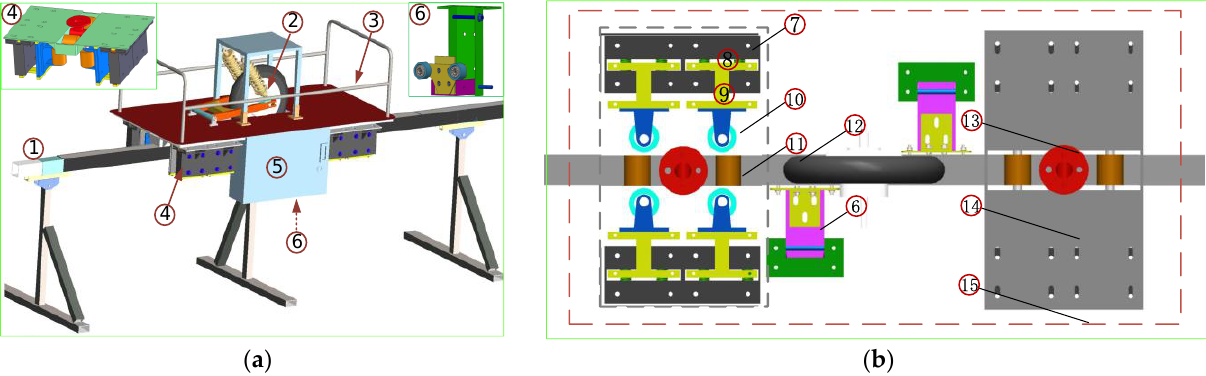
Figure 1. Three-dimensional modeling of the monorail car: 1. track and connecting parts; 2. drive unit; 3. body; 4. chassis; 5. counterweight box; 6. anti-tip device; 7. gap-adjusting frame; 8. spring; 9. I-beam; 10. guide wheel; 11. load-bearing wheel; 12. wheel motor; 13. articulated disc; 14. chassis; 15. body. ( a ) Design of the complete car structure; ( b ) Design of the chassis structure.